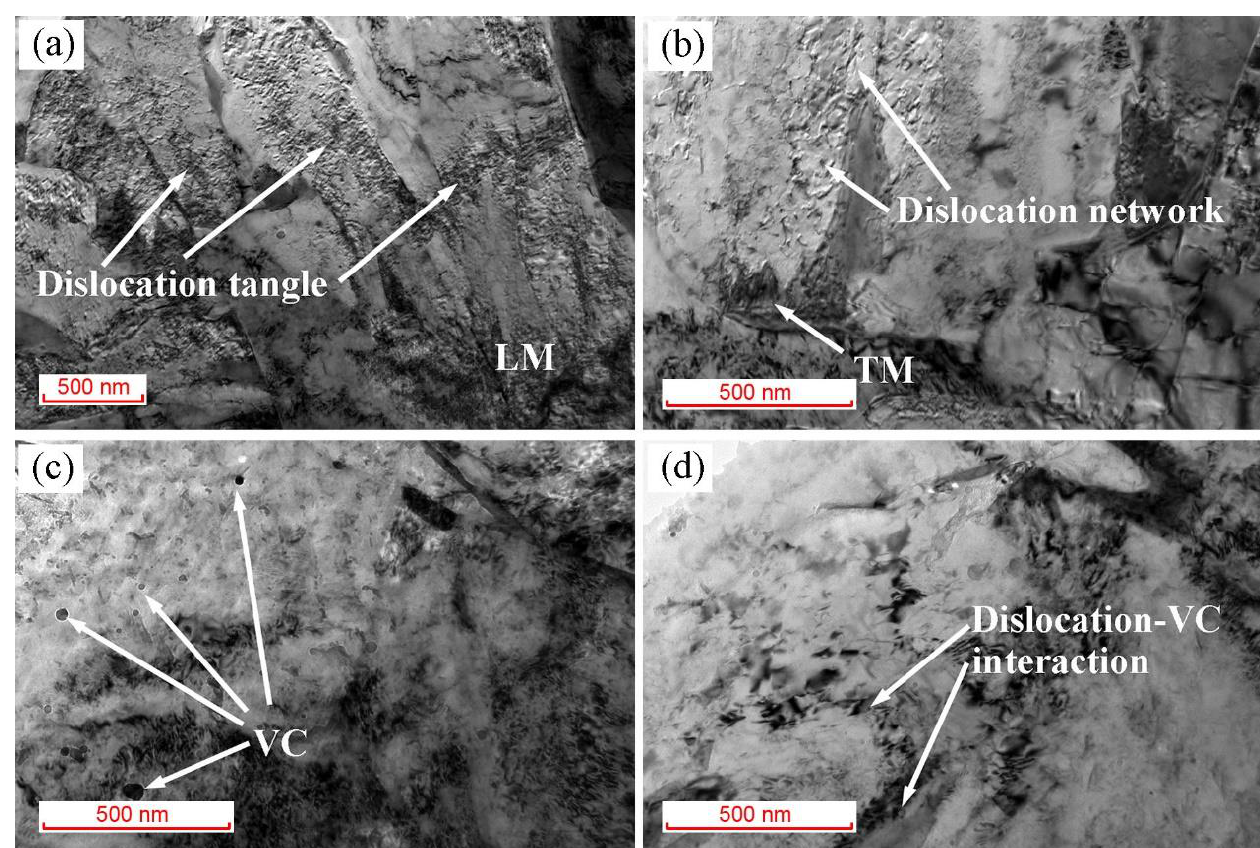
Figure 11. TEM micrographs of 0.16V-2ST_200 specimen: ( a ) dislocation tangle and lath martensite, ( b ) dislocation network and twin martensite, ( c ) vanadium carbide and ( d ) dislocation-VC interaction.